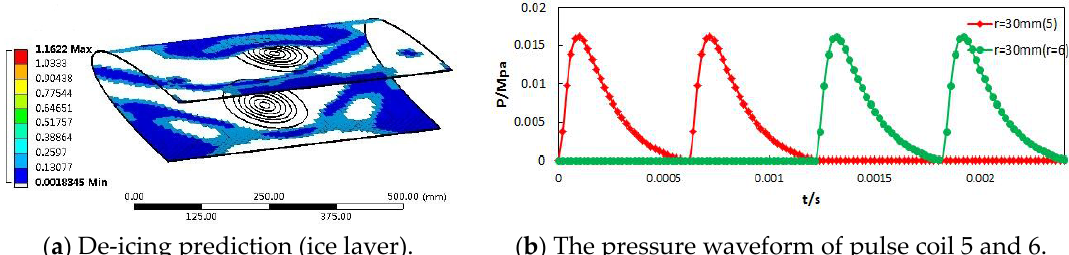
Figure 21. De-icing results of pulse coil 6 starting 1200 μs later than coil 5.